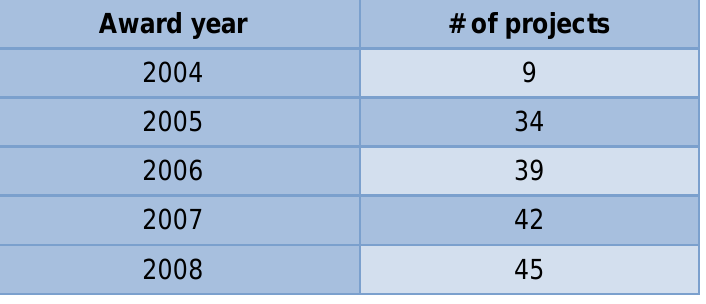
Table 3 Projects number vs. year awarded in the collected data Project Size